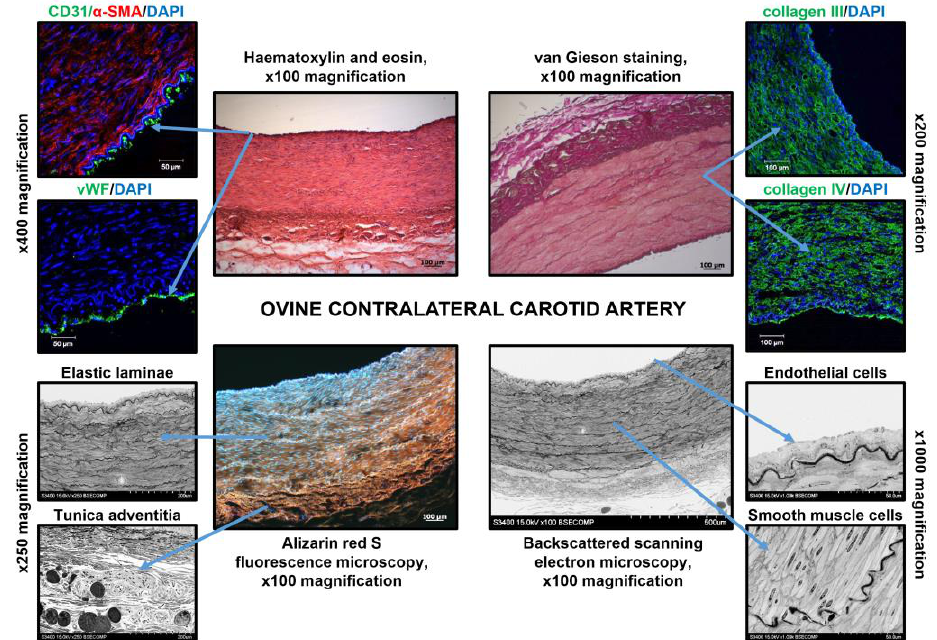
Figure 7. Microscopic examination of the ovine contralateral carotid artery. Centre: haematoxylin and eosin staining, van Gieson staining, alizarin red S staining, and EM-BSEM analysis, ×100 magnification, scale bar: 100 µm (for EM-BSEM analysis, scale bar: 500 µm). Left top: immunofluorescence staining for ECs (CD31 or vWF) and VSMCs (α -SMA), ×400 magnification, scale bar: 50 µm. Right top: immunofluorescence staining for medial collagens (type III and type IV), ×200 magnification, scale bar: 100 µm. Nuclei are counterstained with DAPI. Left bottom: EM-BSEM analysis, lamellar units and tunica adventitia, ×250 magnification, scale bar: 200 µm. Right bottom: EM-BSEM analysis, ECs and VSMCs, ×1000 magnification, scale bar: 50 µm. Note the EC monolayer, regular lamellar units (elastic laminae and VSMCs between them), and collagen-rich tunica adventitia.